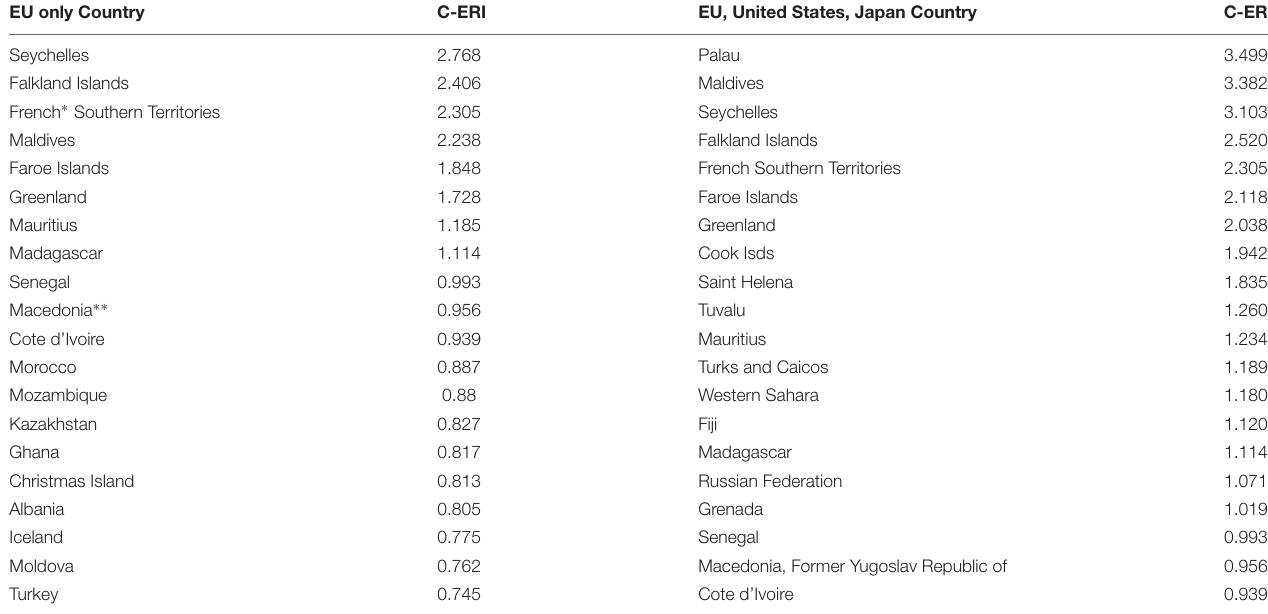
TABLE 6 | Top high carding economic risk index (C-ERI) fish exporting countries to the EU only and to the EU, the United States and Japan combined. EU only Country C-ERI EU, United States, Japan Country